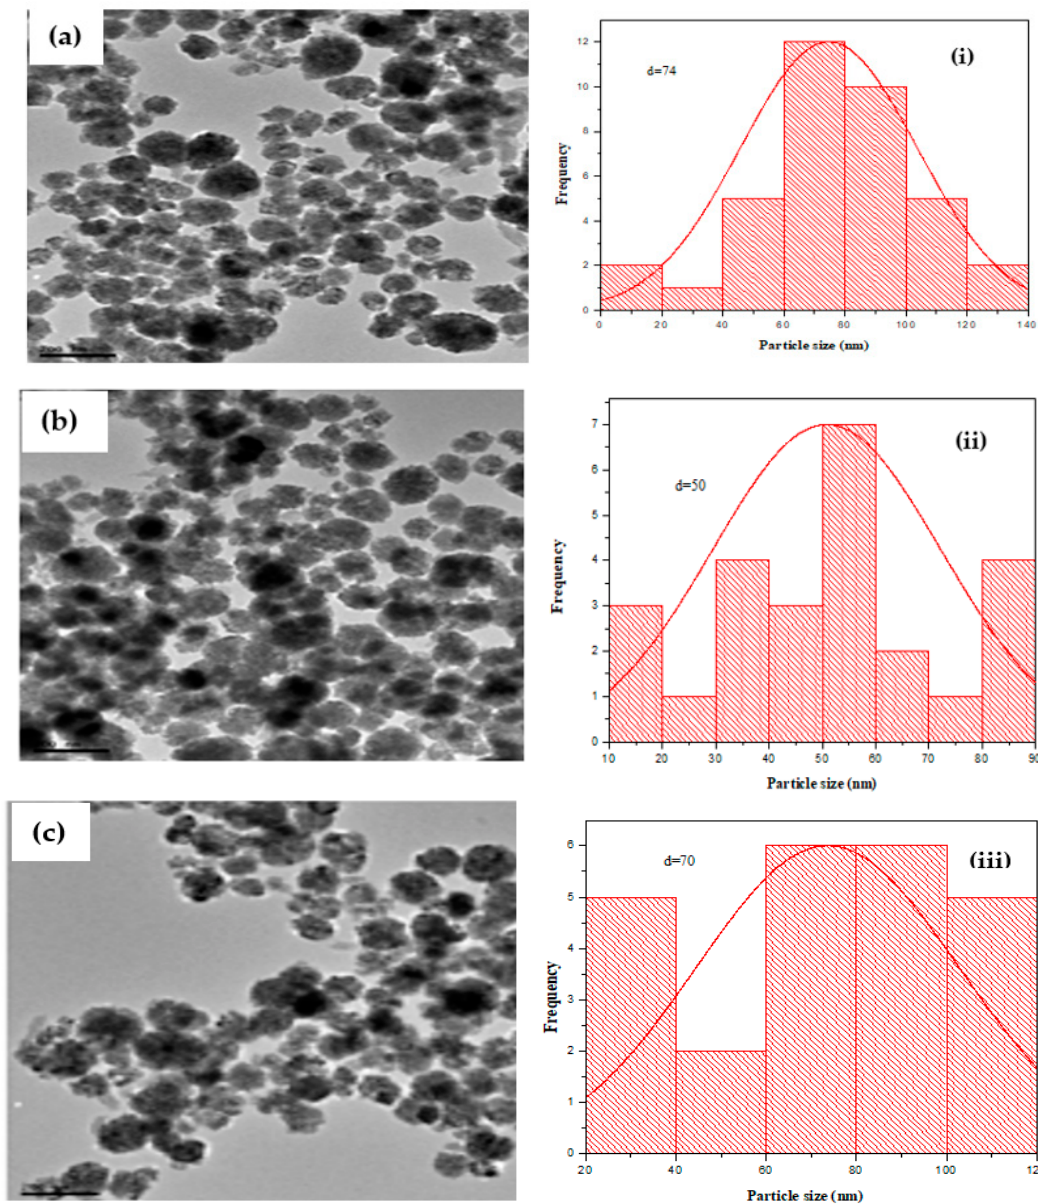
Figure 8. TEM images for ( a ) CuO-NPs-ODI, ( b ) CuO-NPs-LDI and ( c ) CuO-NPs-TDI from orange, lemon and tangerine extracts, respectively, using distilled water as solvent and their size distribution histogram. ( i ) CuO-NPs-ODI, ( ii ) CuO-NPs-LDI and ( iii ) CuO-NPs-TDI.